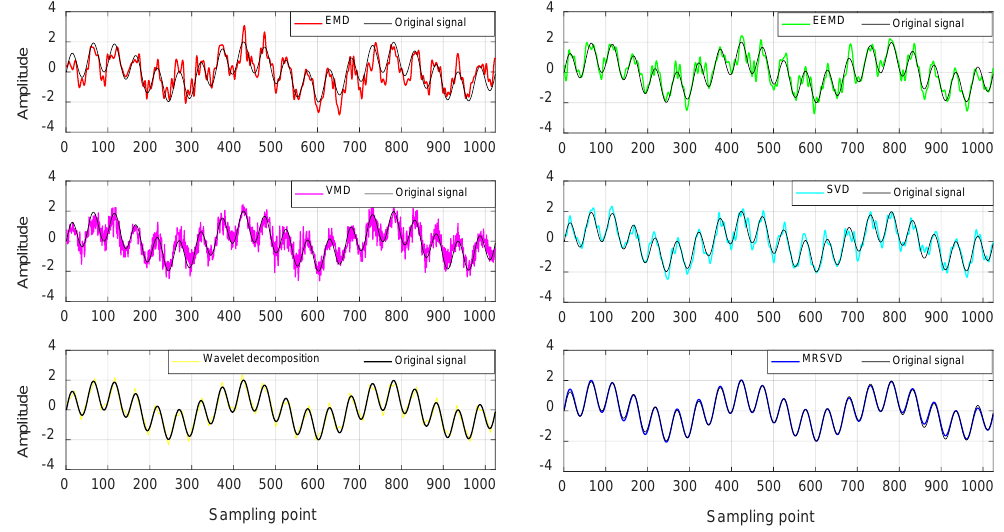
Figure 6. Noise reduction waveform of multiple models on signal x 1 .